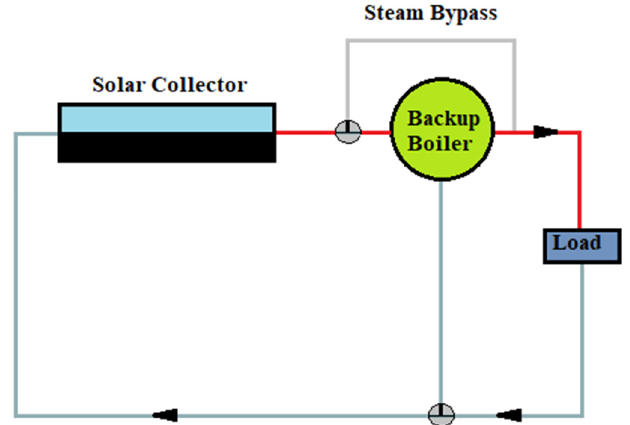
Figure 10. A direct steam generating system with a backup boiler in a parallel connection. Adapted from Ref. [44], Copyright (1985), with permission from Elsevier.